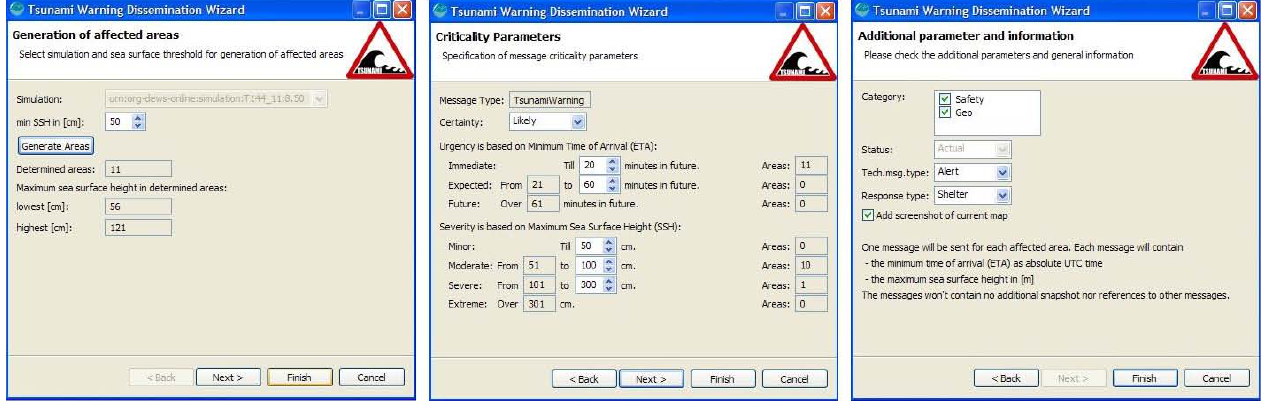
Fig. 8. Tsunami Warning Dissemination